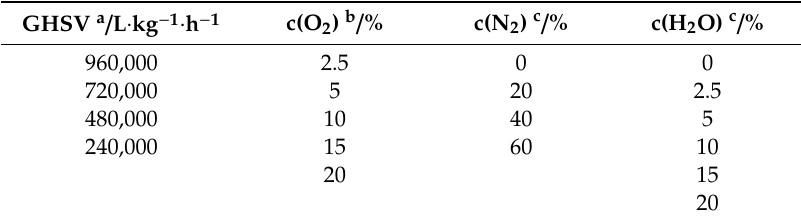
Table 3. Values of parameters for the collection of training data.